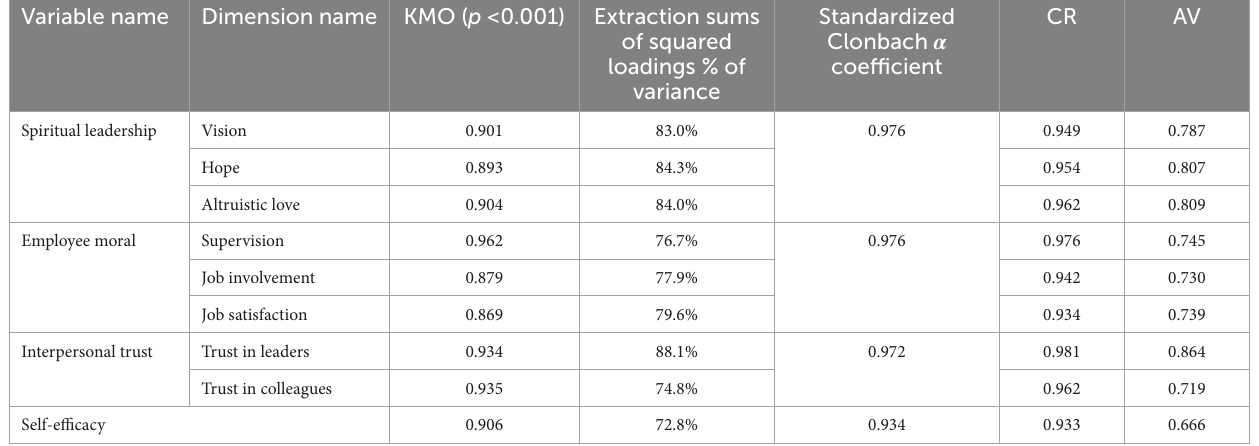
TABLE 3 Extraction of model variables and dimension factors, reliability and validity test table.